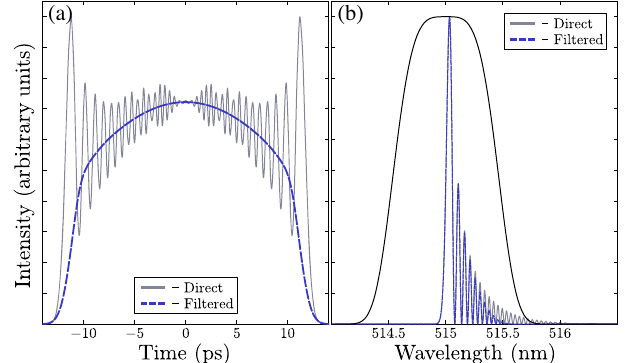
FIG. 3. Genetic algorithm optimized 515 nm laser profile for a bunch length of 1.22 mm resulting in an emittance value of 0 . 30 μ m. Notably, the genetic algorithm settled on a profile which has slower rise and fall times than an ideal flat top as emittance is optimized rather than profile shape. The two plots shown are (a) the laser profile in time before (grey) and after (blue, dashed) a 0.5 nm spectral filter and (b) the spectrum of the pulse before (grey) and after filtering (blue, dashed) with the super-gaussian spectral filter in black.